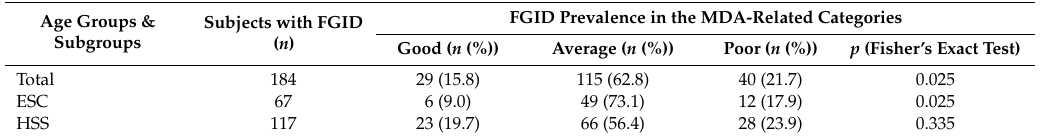
Table 3. Prevalence of FGIDs in the three MDA-related categories in participants with FGIDs and the respective two age-related subgroups.